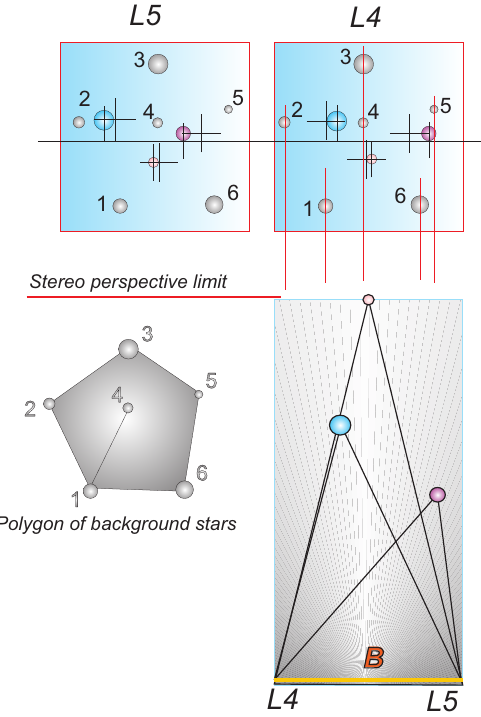
Fig. 3. Understanding stereo perspective in the OStSO and its measurement. Beyond the range where two directions become indistinguishable within error σ res , there are “background” stars 1,. . . ,6 and so forth that make a polygon, same in both images to within σ res and serving as a reference for obtaining mutual displacements and hence instantaneous parallaxes of closer